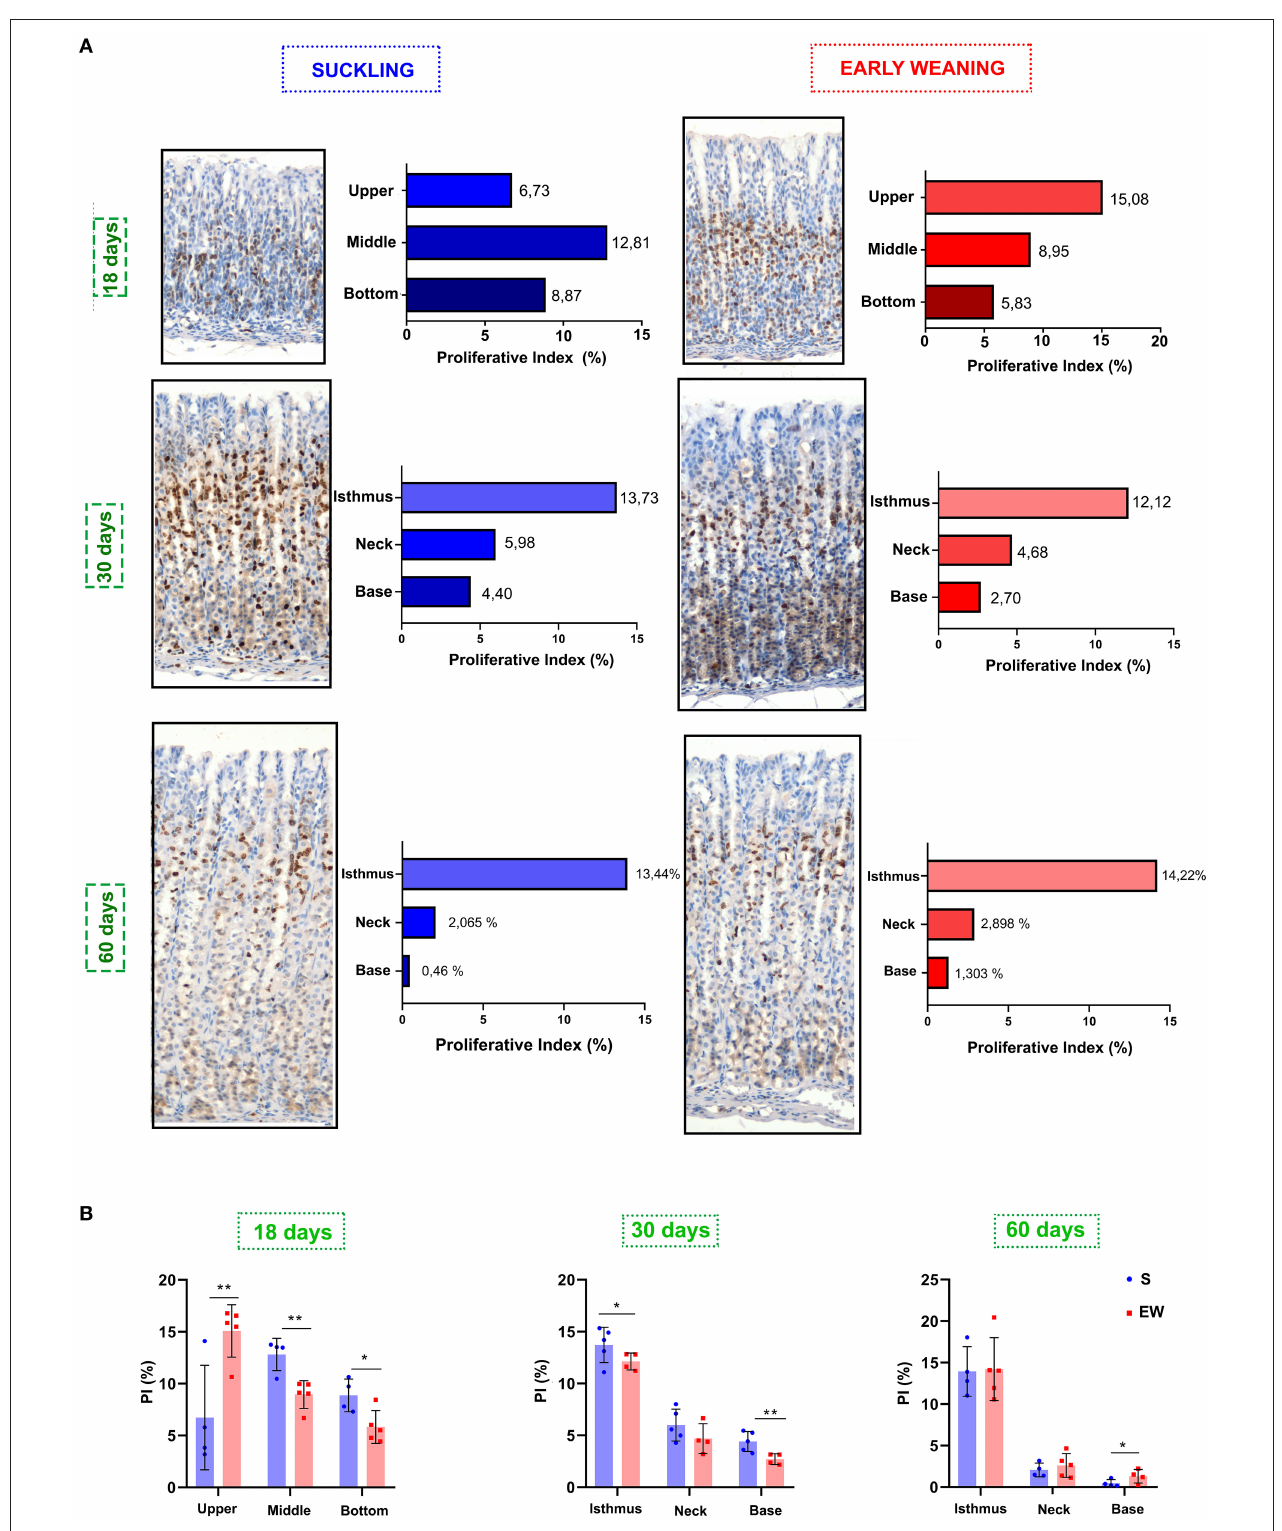
FIGURE 2 | Ki-67 distribution in the gastric mucosa. (A) The gland areas were delineated at 18 (as upper, middle, and bottom), 30 and 60 days (as isthmus, neck, and base). Bar graphs show the distribution of Ki-67, and results are represented by means for S (blue bar) and EW (red bar). (B) Comparison of the distribution of proliferative cells among S and EW. Each point represents the result obtained in an animal, and the lines indicate the mean ± SD. * p < 0.05; ** p < 0.01 ( n = 5–6/group).